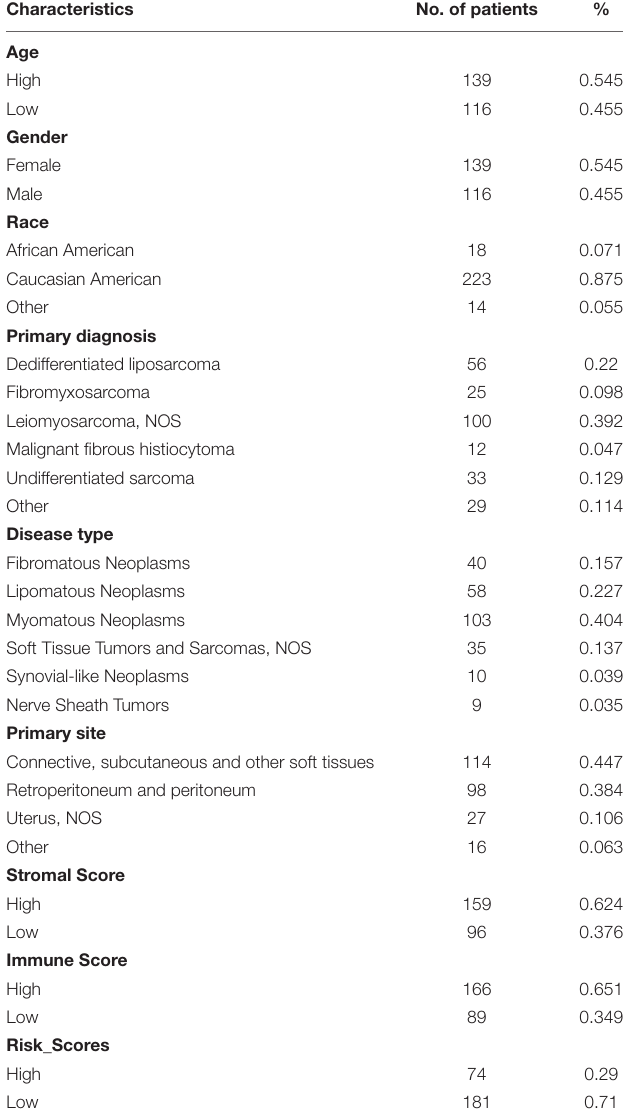
TABLE 1 | The clinical characteristics of patients with SARC.